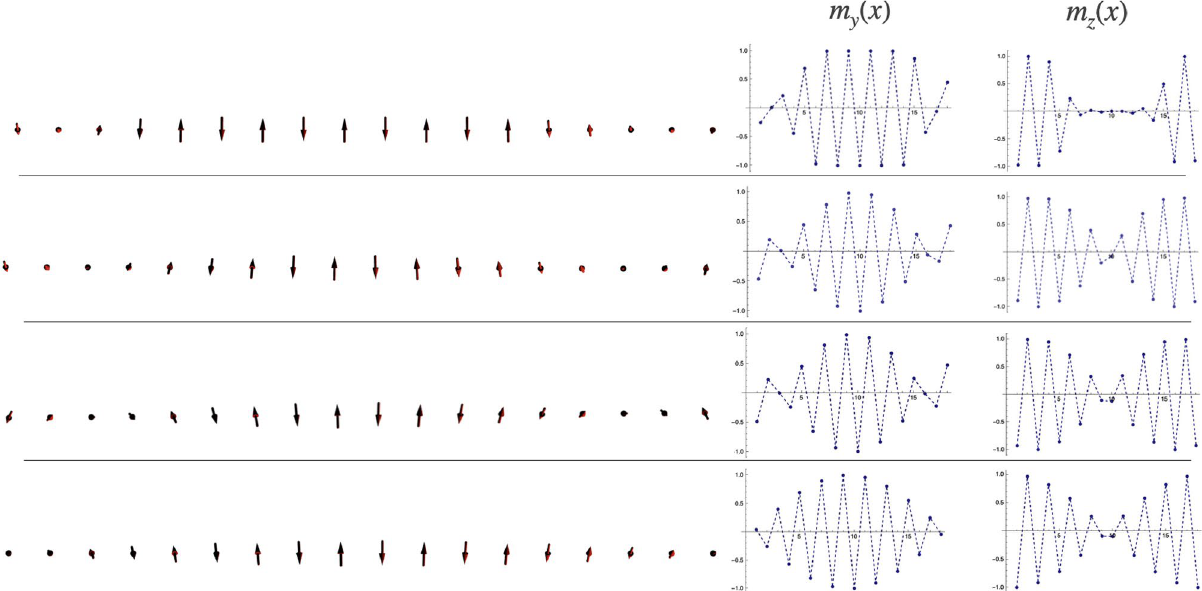
0.95 . The right panel shows the magnetization of each dipole in p ℓ up to ℓ ∼ ∼ ∗